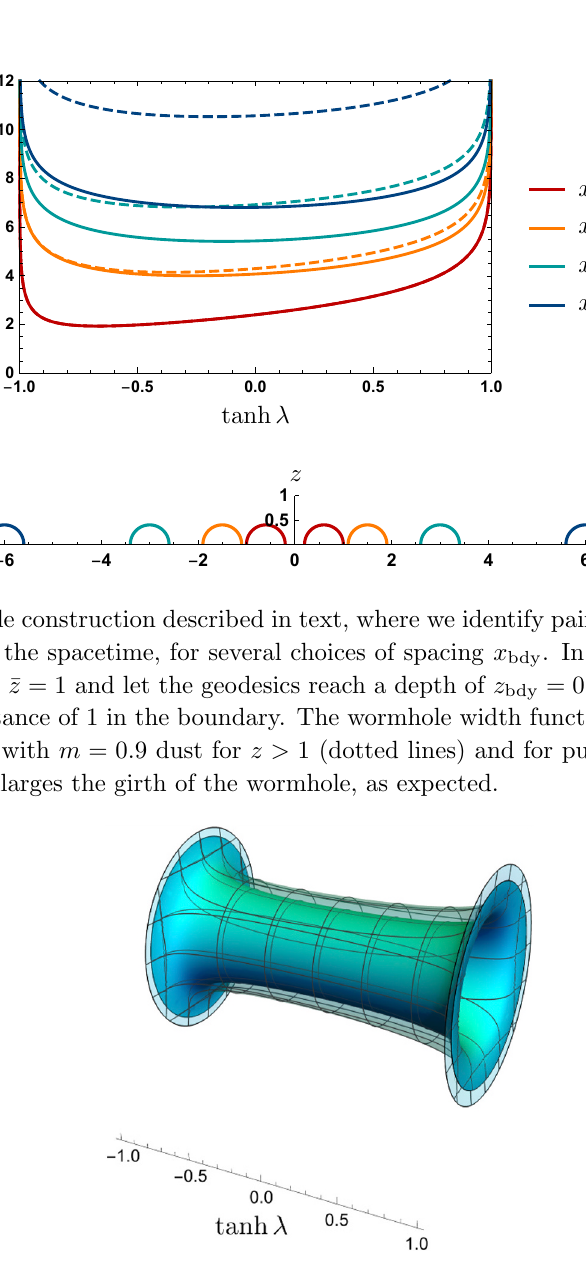
bdy = 3. The vacuum